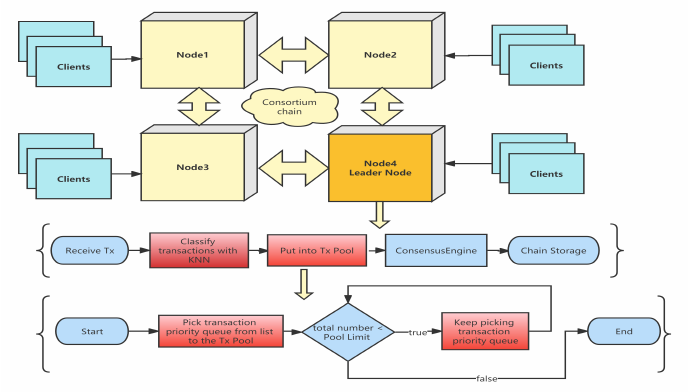
Figure 3. The KNN-enabled PBFT consensus